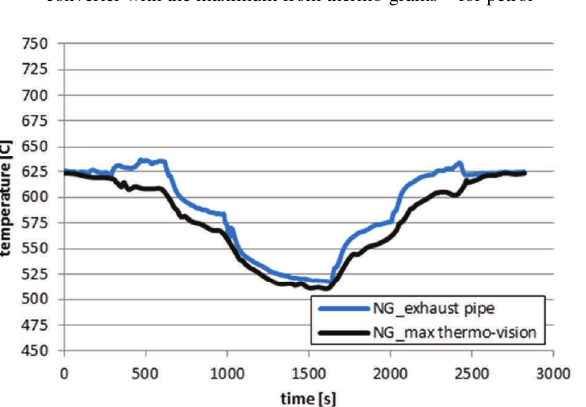
Fig. 8. Comparison of temperature values in the pipe behind the catalytic converter with the maximum of thermo-grams for natural